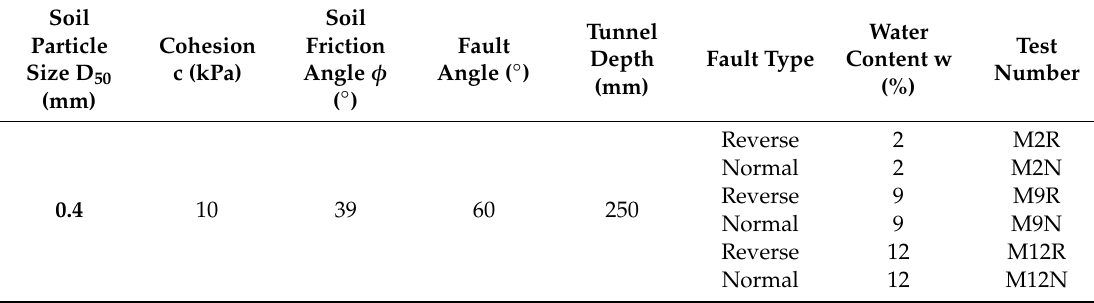
Table 1. Soil properties used for various water content.